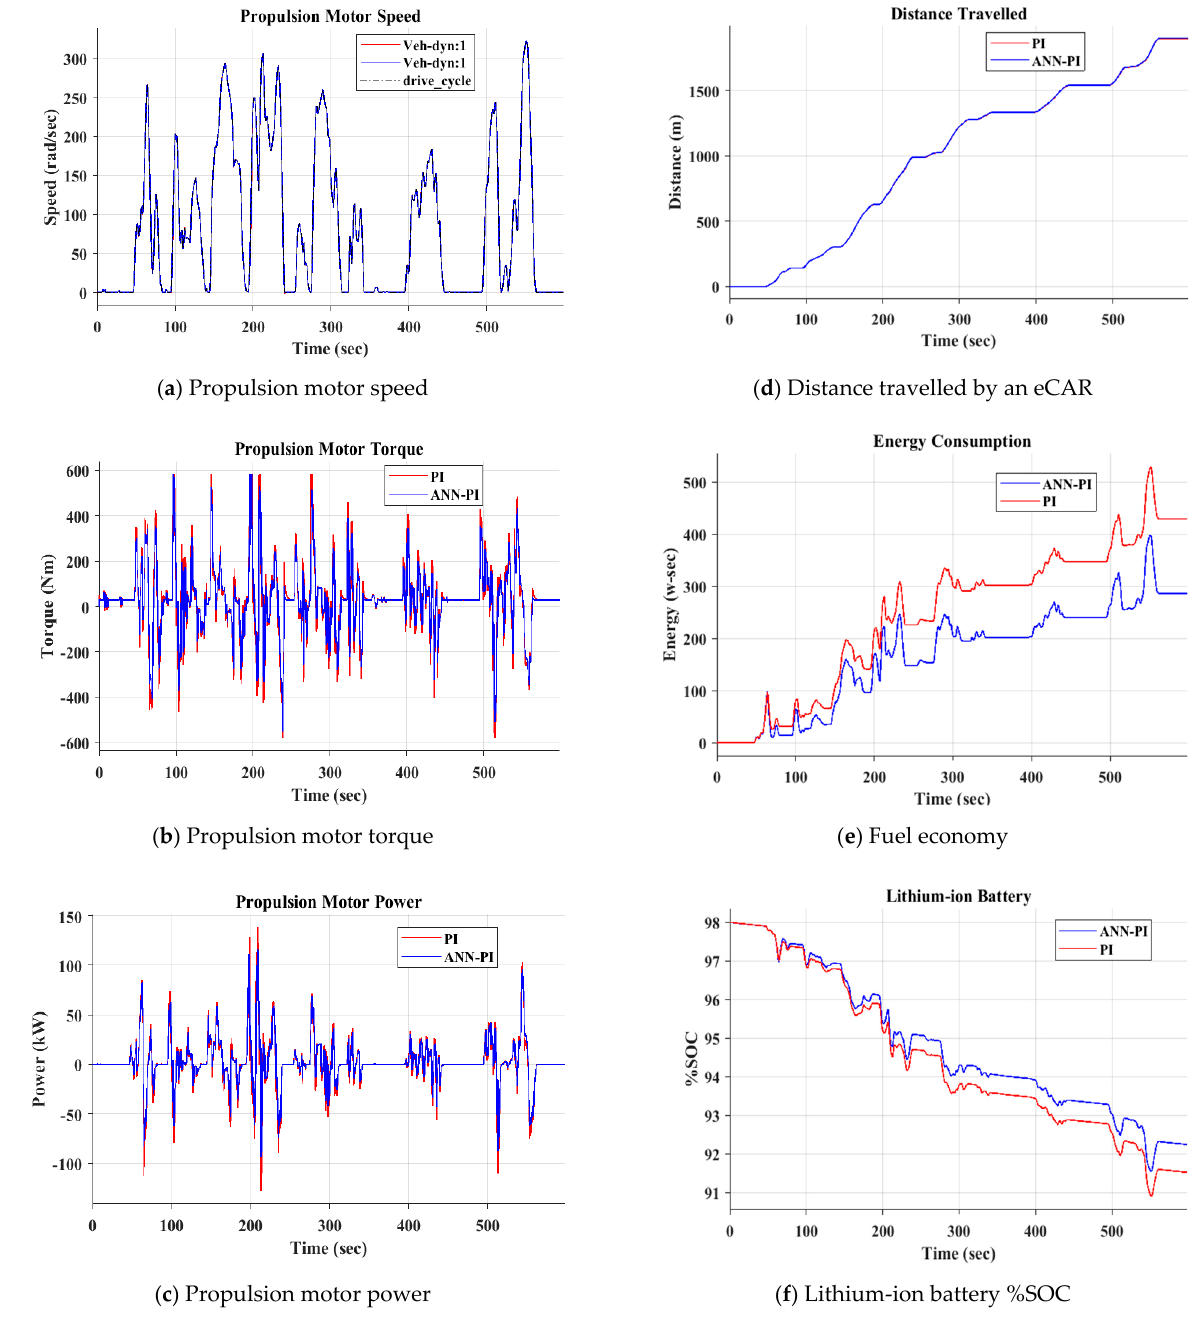
Figure 19. The performance of an eCAR with a conventional torque controller and an ANN tuned PI controller under an NYCC cycle. Table 6. Motor Performance Analysis Under a One Cycle Simulation Test.